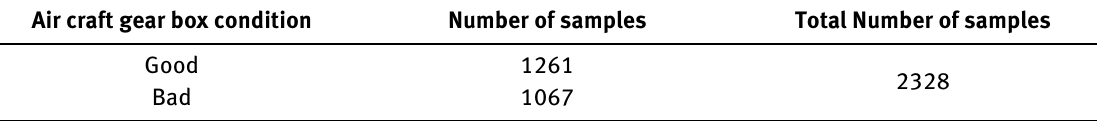
Table 2: Derived Aircraft gearbox vibration dataset Air craft gear box condition